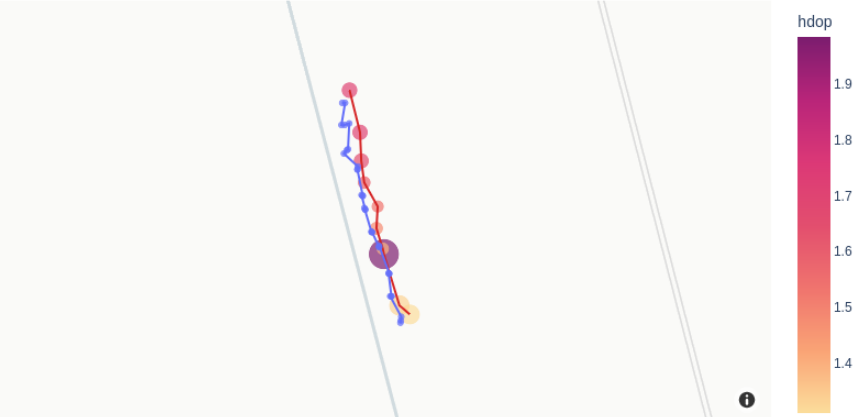
Figure 5. Positions measured with a Garmin GPS (blue circles) overlapped with the same positions measured with the GPS of the MD (yellow to red), at the tortoises’ study site. The radius of the circles indicates the measurement error assessed as explained in the text for each methodology. Hdop stands for horizontal dilution of precision.